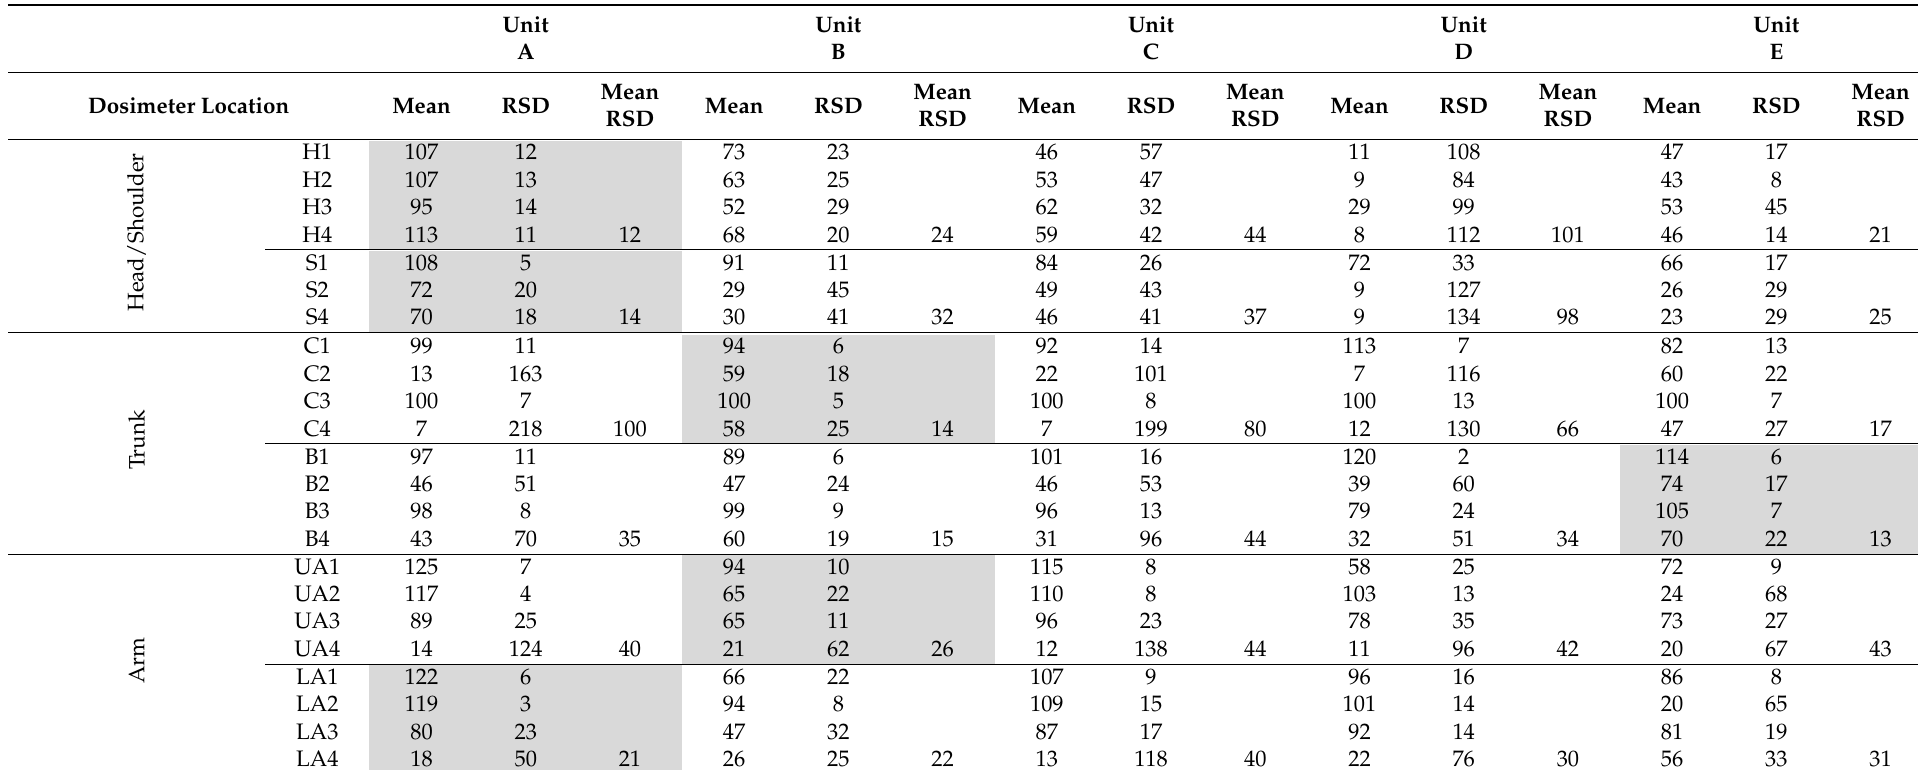
Table 2. Mean dosimeter readings in % of C3 dosimeter readings for all participants combined. Values for 31 dosimeters on various body locations as measured in five different treatment units. To compare the UV distribution in the five treatment units, SD was divided by the mean of measurements (relative standard deviation = RSD). The lower the RSD, the more even the distribution. Pale grey indicates the unit with the lowest RSD in a specific area. Individual measurements of all participants are shown in Supplementary Material, Tables